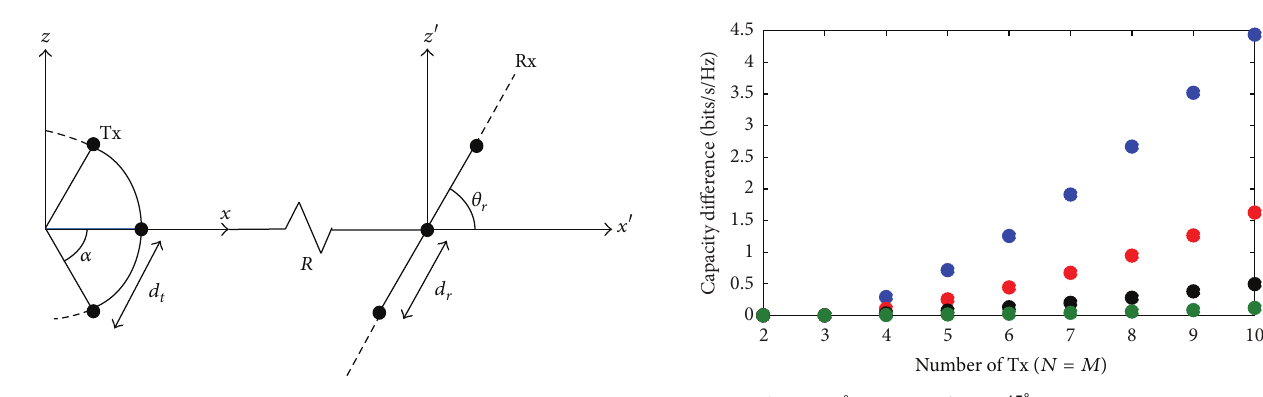
Figure 1: Geometry of the proposed system.